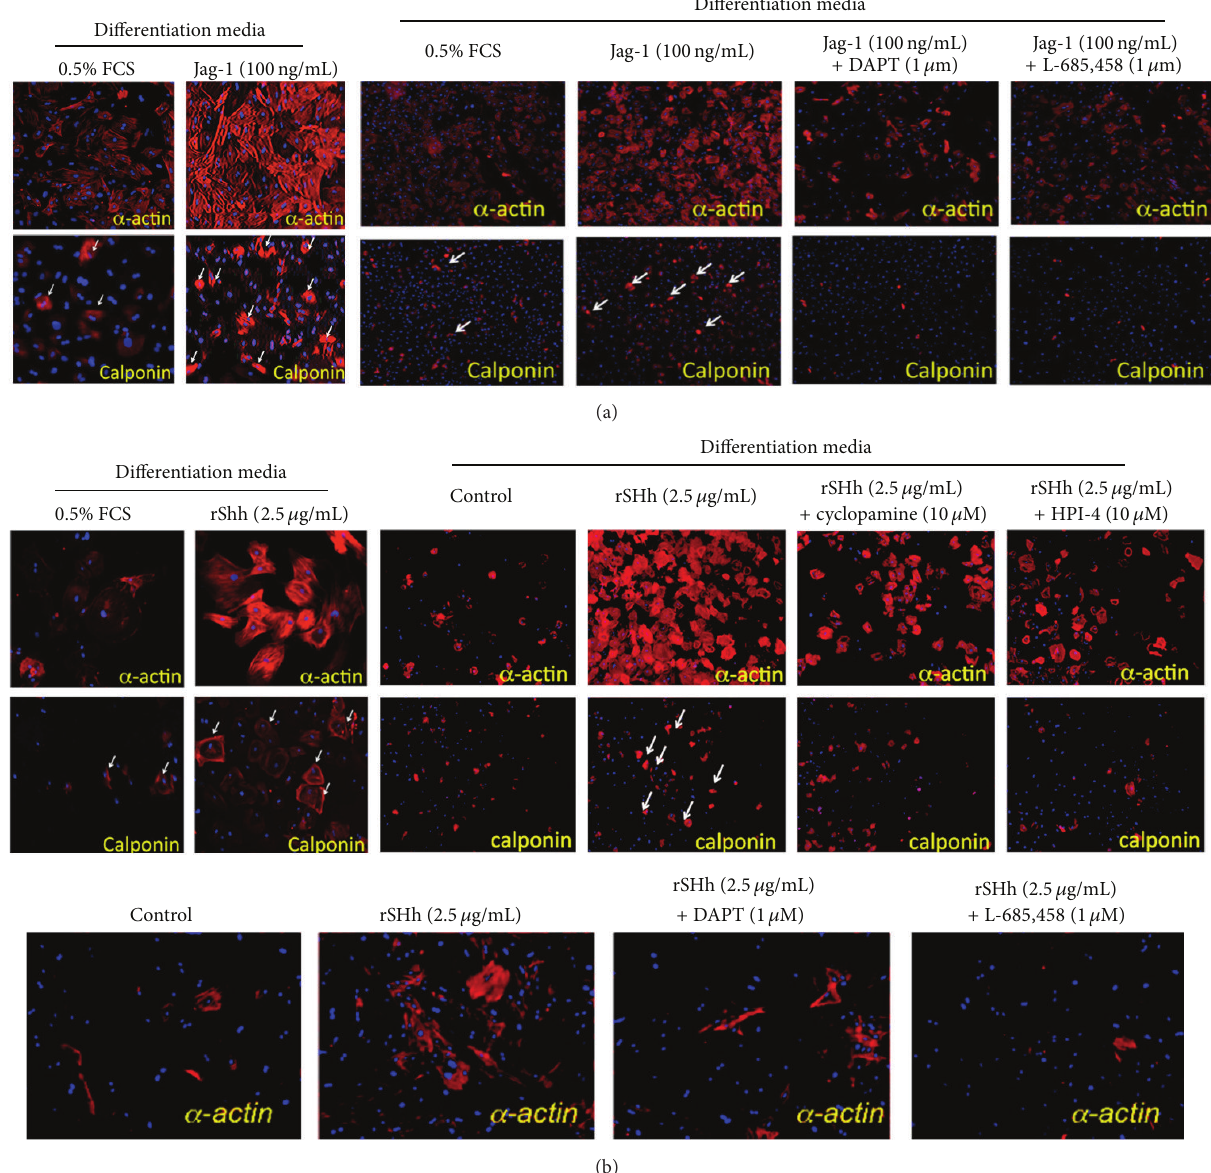
Figure 6: Hedgehog and Notch control of mesenchymal stem cell (MSC) transition to vSMC. Rat MSCs were treated with recombinant rSHh or the Notch ligand, Jagged-1, for 5 days in 0.5% FCS in the absence or presence of Hh (cyclopamine and HPI-4) and Notch inhibitors ( 𝛾 -secretase inhibitors, DAPT and L-685,458). Vascular SMC differentiation was assessed by determining smooth muscle 𝛼 -actin (SMA) and calponin-1 (CNN1) positive